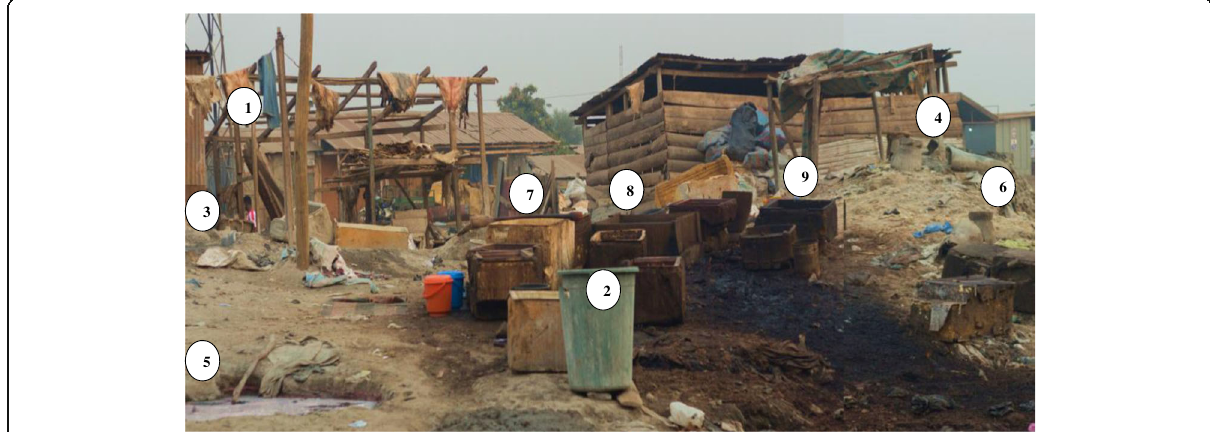
Fig. 1 Tannery site in Ashanti Region 1 Curing (drying) 2 Soaking 3 Liming 4 Unhairing 5 Deliming & Bating 6 Fleshing 7 Vegetable tanning 8 Red dyeing 9 Black